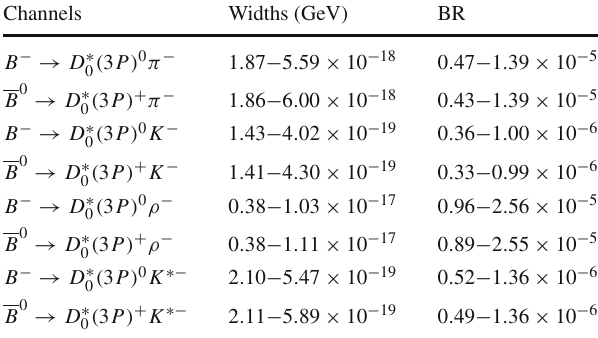
Table 7 Non-leptonic production results of the 2 P state D ∗ Channels